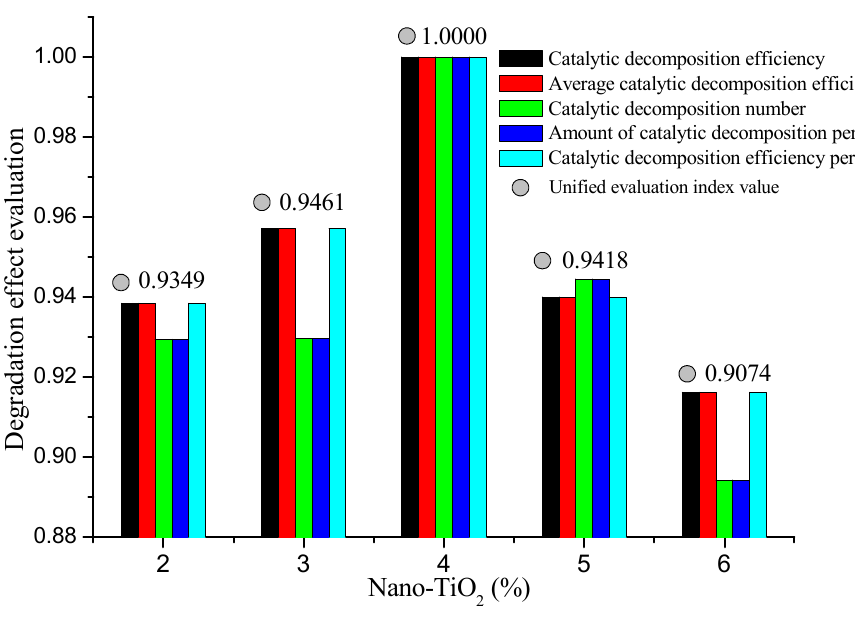
Figure 7. Effect of the coating degradation.